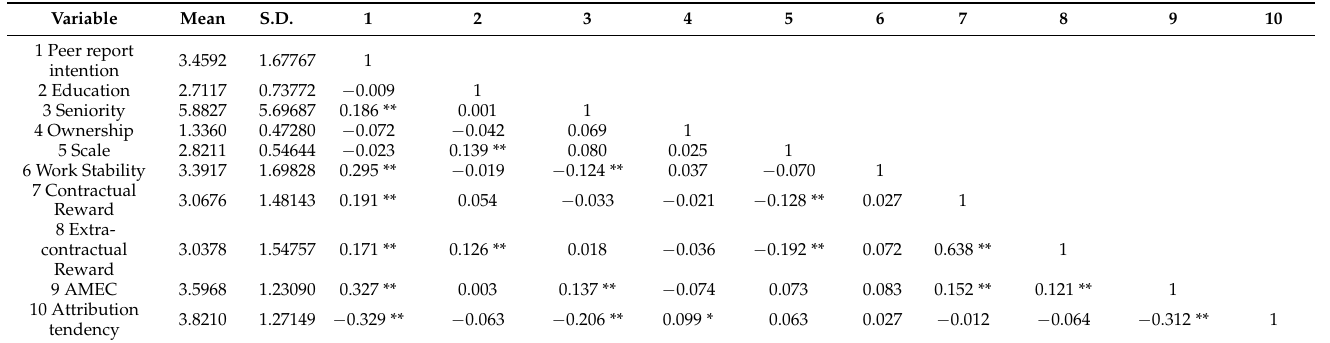
Table 2. Means, Standard Deviations and Correlations.